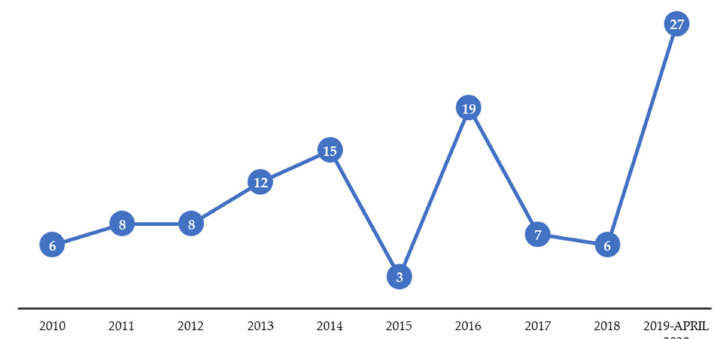
Figure 2. Cosmetic recalls in the EU market due to microbiological contamination in the last